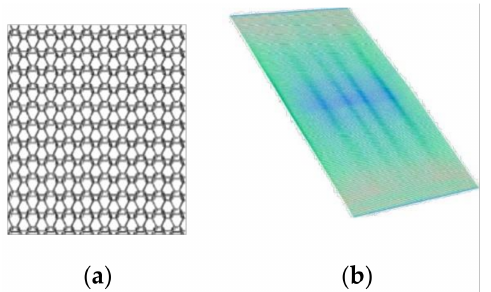
Figure 1. ( a ) Knitted textile made of stretchable yarns; ( b ) folding simulation under tension.